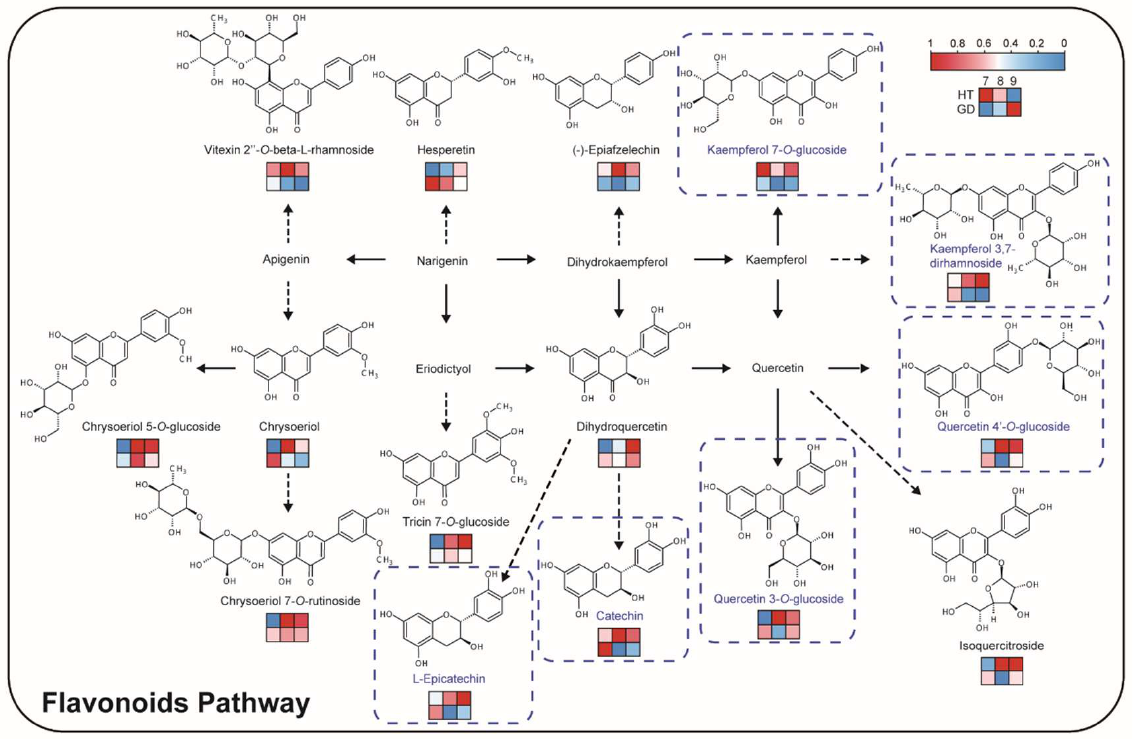
Figure 5. Flavonoid biosynthesis pathway in the coconut flesh. The heatmaps are drawn according to the relative content of metabolites, and the contents of each metabolite are normalized. Columns and rows in the heatmap represent stages and varieties, respectively. In each heatmap, the upper row represents HT, the lower row represents GD. In the columns of each heatmap, 7M, 8M and 9M are represented from left to right. The metabolites with blue frames have a bitter